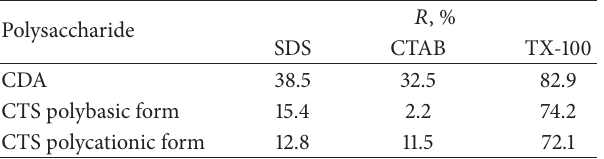
Table 3: Pyrene extraction degree at its sorption from aqueous micellar solutions on CDA and CTS